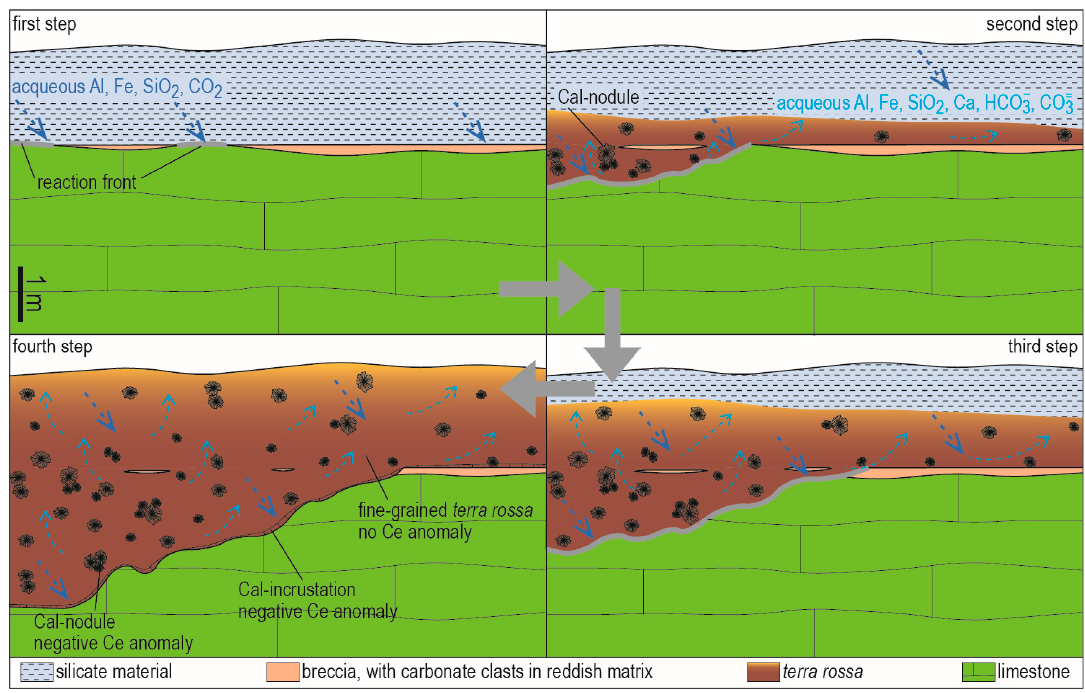
Figure 10. Synoptic cartoon showing four schematic steps for the progressive formation of the terra rossa in the study area (see text for further explanations). terra rossa in the study area (see text for further